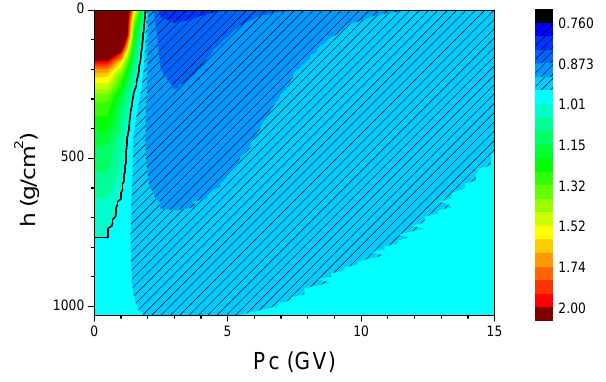
Fig. 3. The relative ionization effect C (see text for definition) of GLE 20 January 2005 as function of the geomagnetic cutoff rigidity P c and atmospheric depth h . The region of suppression ( C < 0.99) effect is hatched, while the solid curve bounds enhancement ( C > 1 . 01) effect.